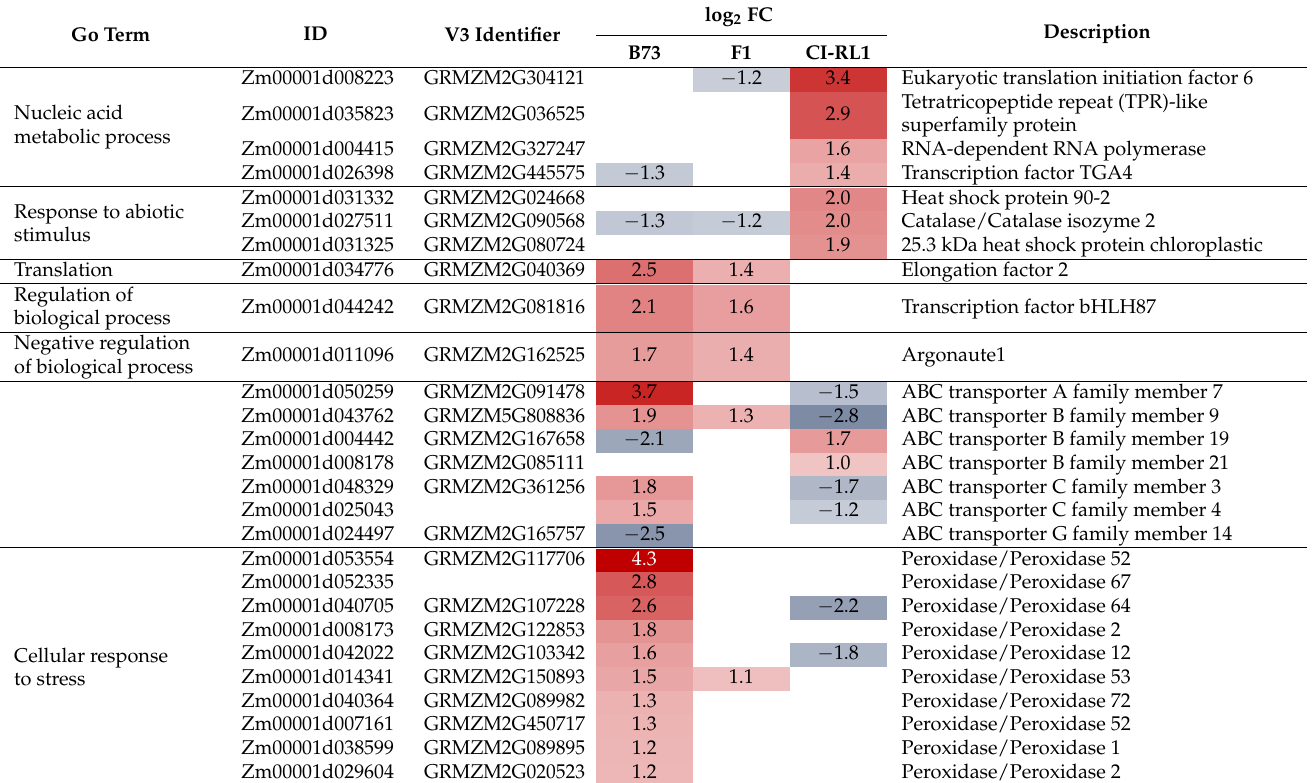
Table 2. Thirty-two candidate genes selected using different criteria. Down- (in blue) and upregu- lated (in red) genes, maize transcript IDs, V3 identifiers, fold-change expression levels (log 2 ), and descriptions as reported in the Monocots PLAZA 4.5 database are presented. The candidates with a gray background were below the selection criteria threshold for